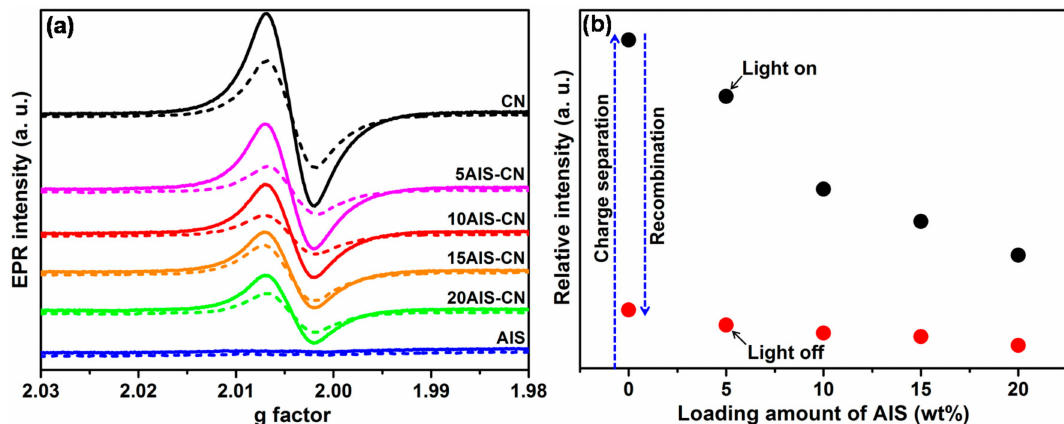
Figure 5. ( a ) Electron paramagnetic resonance (EPR) signal of CB-e − in as-prepared catalysts (without Pt) during UV-vis irradiation (solid lines) and after light switched-off (dashed lines); ( b ) Double integral of the EPR CB e-signal intensity (initial background signal in the dark subtracted) during UV-vis light irradiation (black dots) and after light switched-off (red